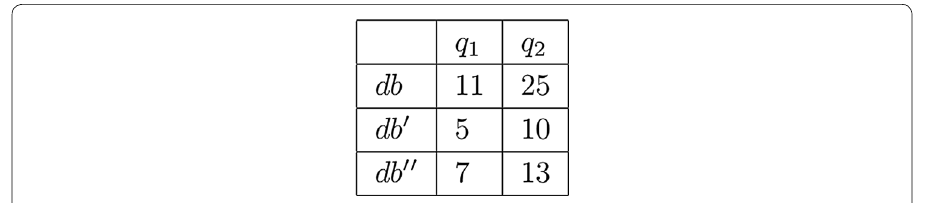
Fig. 8 Performance when changing functor (in ms)